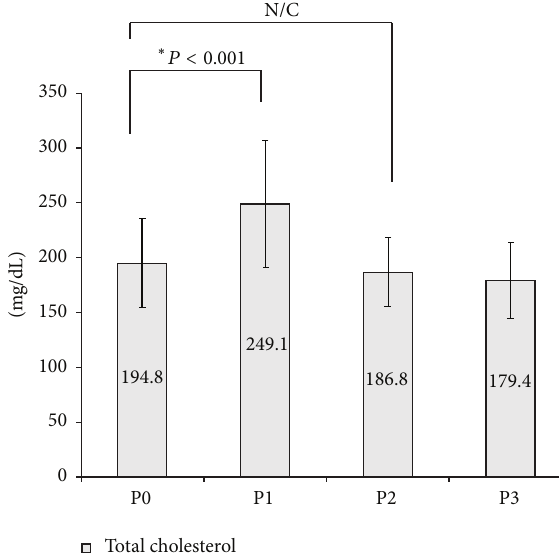
Figure 1: The serial change of mean total cholesterol